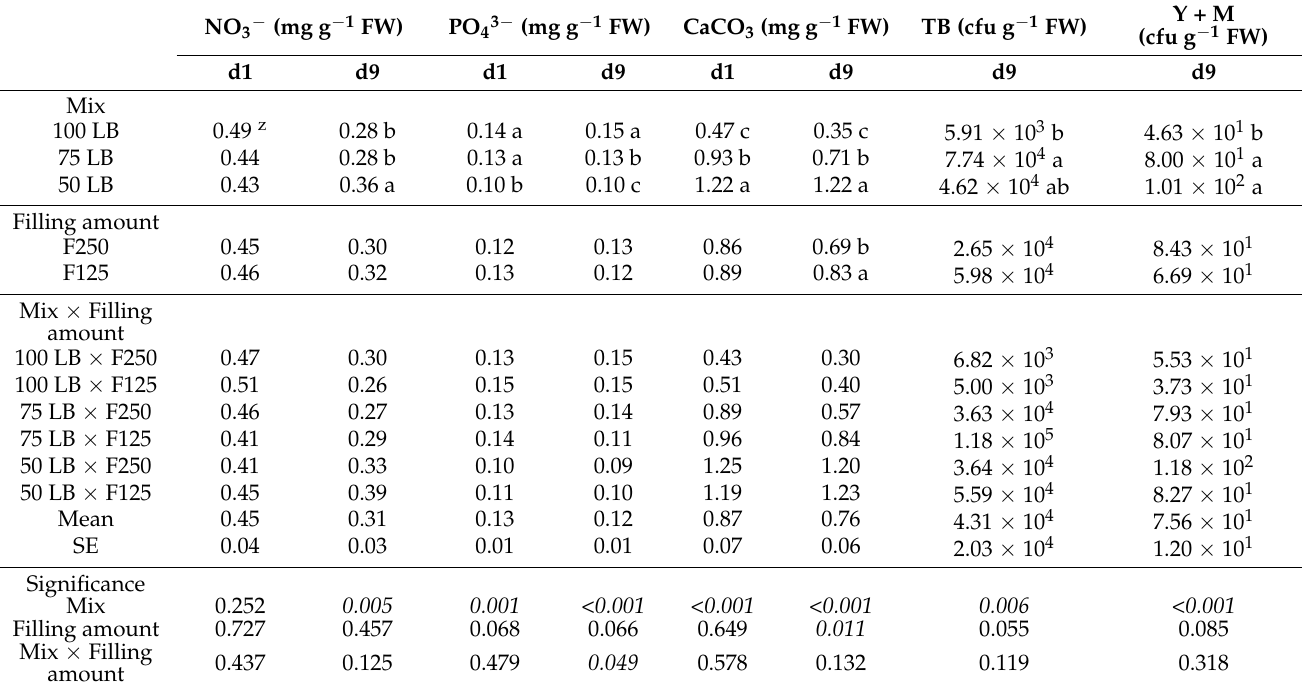
Table 5. Ion and salt contents of the tissue, and microbial contamination in the fresh-cut baby leaf lettuce and rocket during